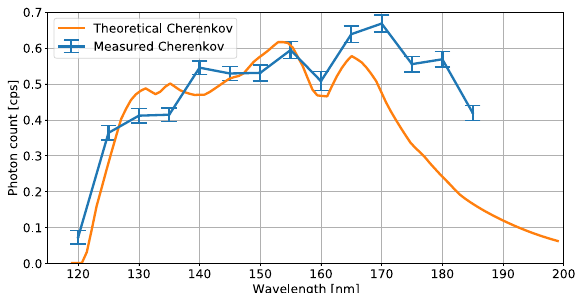
229 Figure 6. The detected VUV spectrum of a Th:CaF 2 crystal compared to a theoretically computed Cherenkov spectrum that takes into account the spectral efficiency of the system. See “Methods” for a description of the measurement